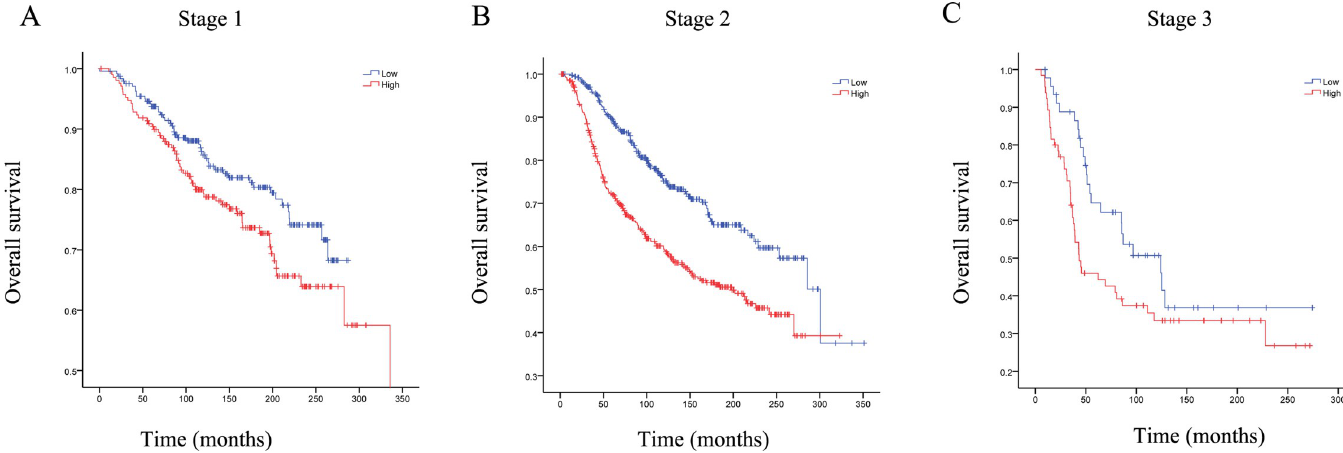
Fig 7. The effects of RRM2 high expression and low expression on the overall survival of breast cancer patients. Our study found that the RRM2 high expression group had a poor prognosis among stage1 and stage2 breast cancer patients. However, there was no significant difference in stage3. (A) stage 1; (B) stage 2; (C) stage 3.